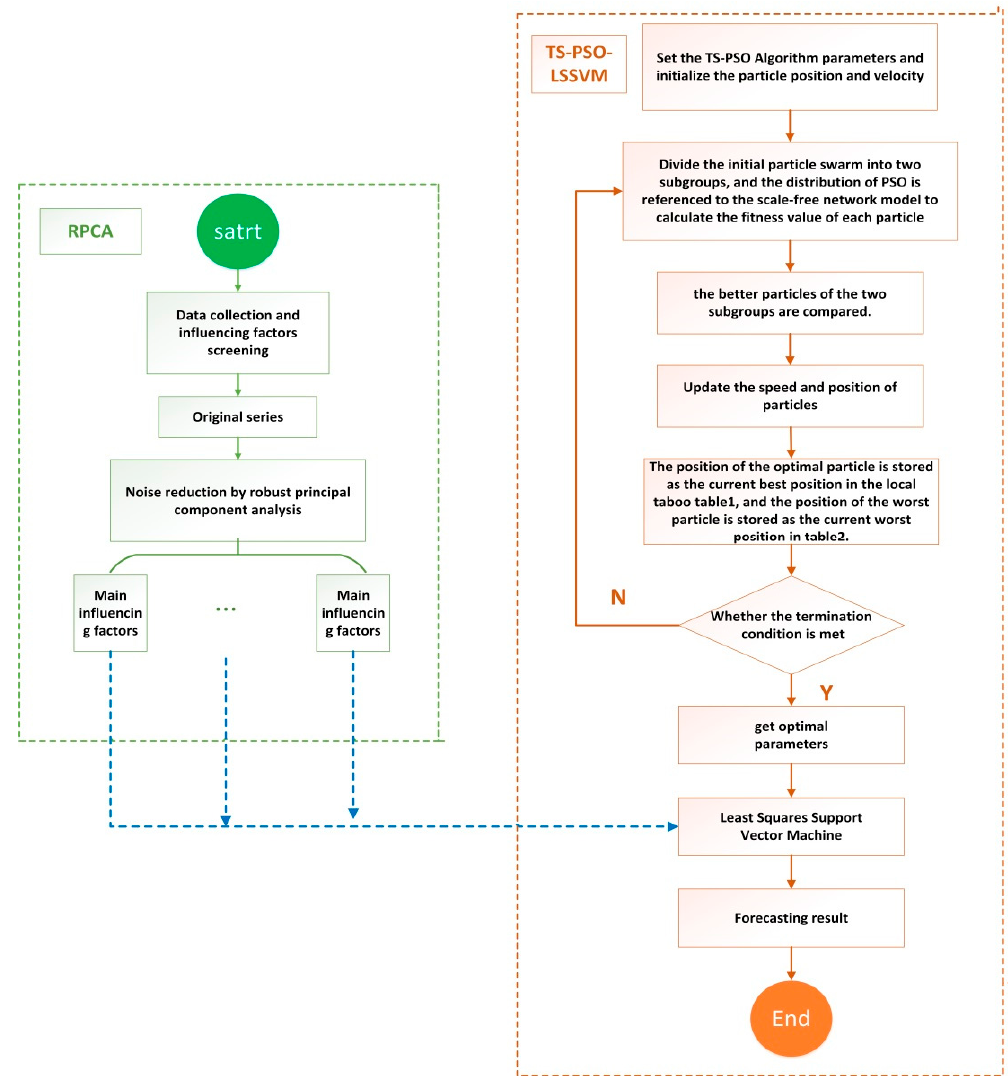
Figure 3. The forecasting process based on the RPCA-TS-PSO-LSSVM (Robust Principal Component Analysis and PSO-LSSVM Optimized by the Tabu Search) model.